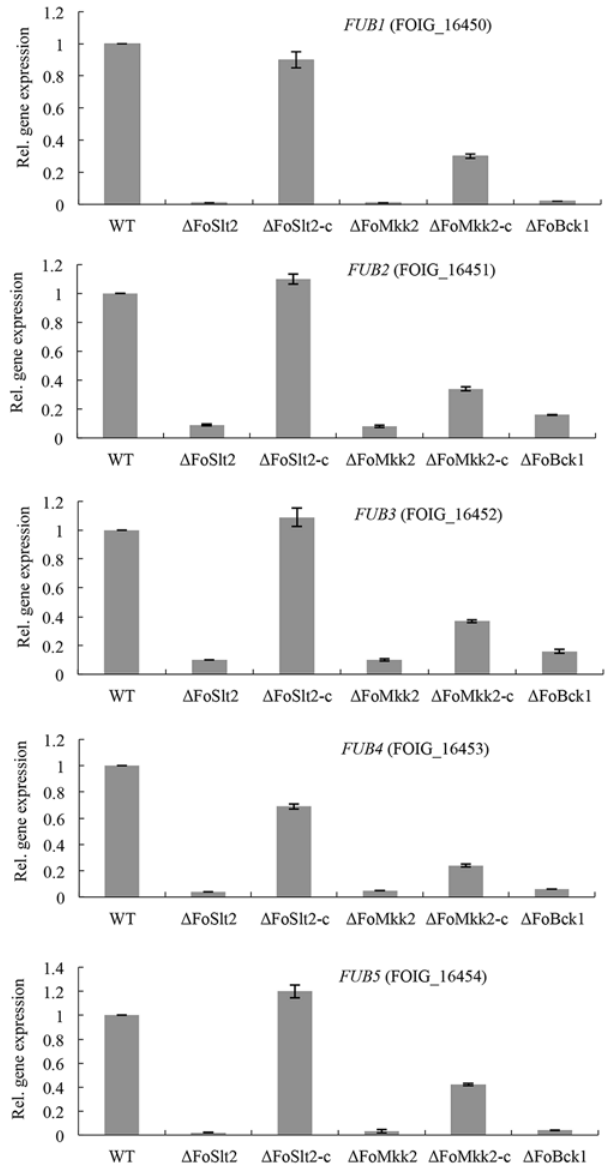
Fig 7. The MAP kinases regulate transcription of the fusaric acid gene cluster. Gene expression levels are represented relative to WT using quantitative real-time PCR. Error bars indicate the standard error from three